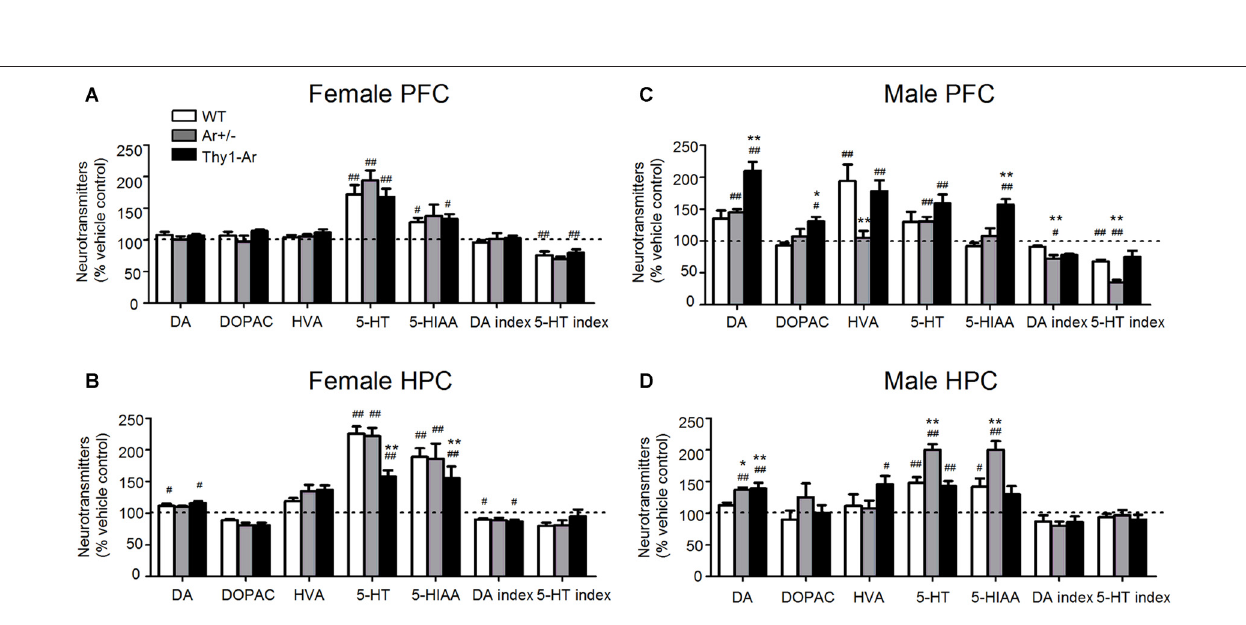
FIGURE 4 | Sex differences in the effect of duloxetine on DA and 5-HT index in the PFC and HPC. The effect of duloxetine on DA and 5-HT index of three genotype in female PFC (A) , female HPC (B) , male PFC (C) and male HPC (D) . # Indicates P < 0.05 and ## P < 0.01 compared to vehicle-treated, ∗ indicate P < 0.05 and ∗∗ P < 0.01 compared to WT mice. n = 6–7